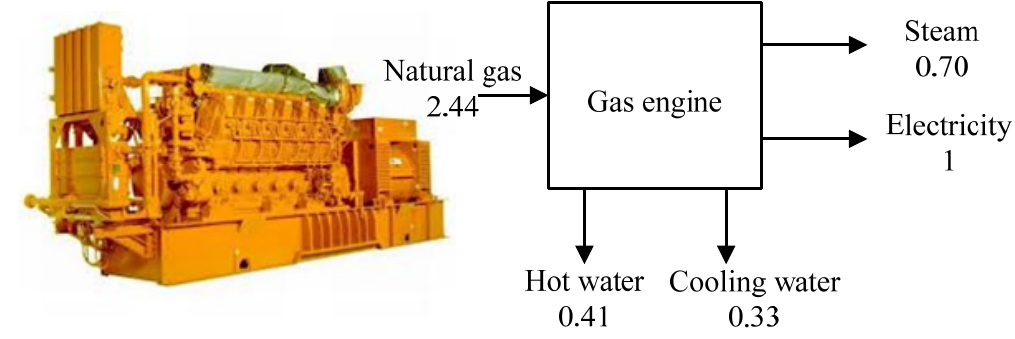
Figure 4. Showing (LHS) a cut-away diagram of a Cat® G3616 gas engine [36] and (RHS) the energy flows for this technology normalized to the electrical energy output. ( Reprinted courtesy of Caterpillar